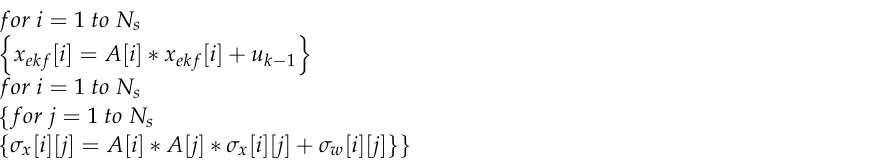
Algorithm 1: Compute state and error covariance time update